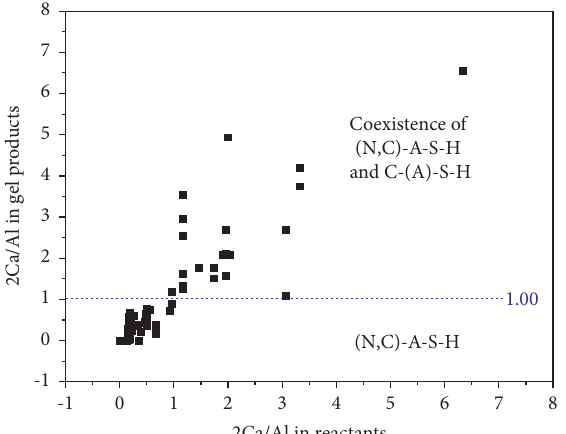
Figure 7: The 2Ca/Al data and detected products by testing in gel products and reactants (the premise is Si/Al > Table 6: The 2Ca/Al ratios in products and the detected gel products of PST3 and controls. Samples SR content